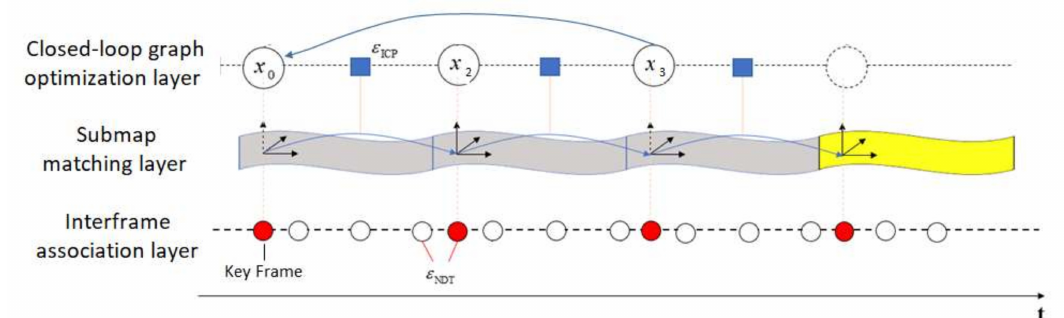
Figure 4. Framework of the three-layer point cloud association technique. In the interframe association layer, the red points represent key frames; in the submap matching layer, the grey submaps denote that they have been matched, the yellow submaps are waiting for matching and in closed-loop graph optimization layer, x i denotes the pose of the i -th key